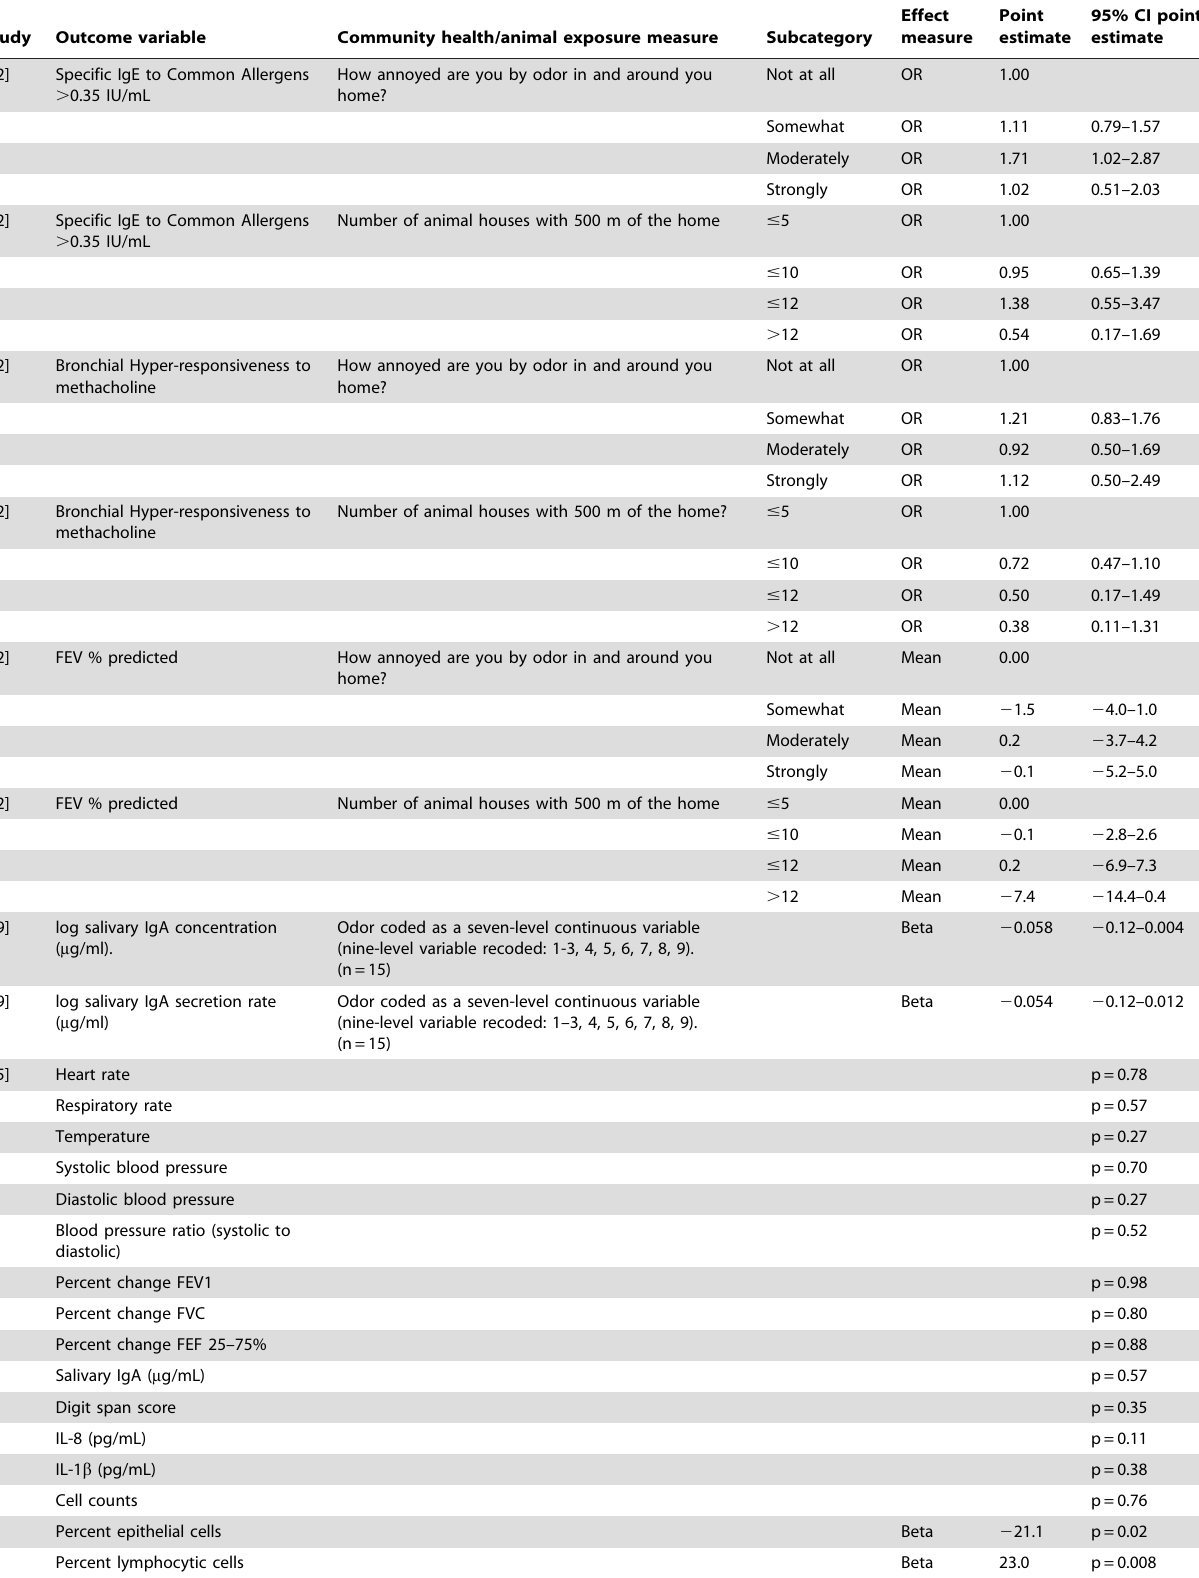
Table 3. The reported adjusted* association between clinical outcome variables and measures of proximity to